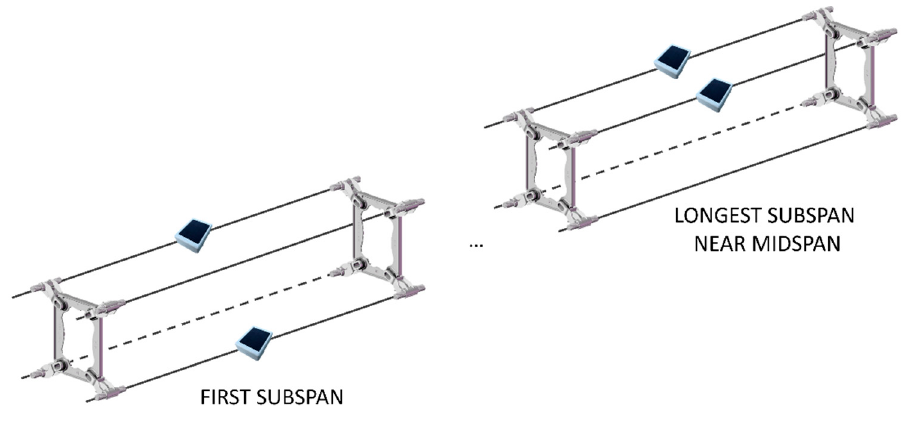
Figure 6. Schematization of possible sensor nodes positioning on a quad bundle.